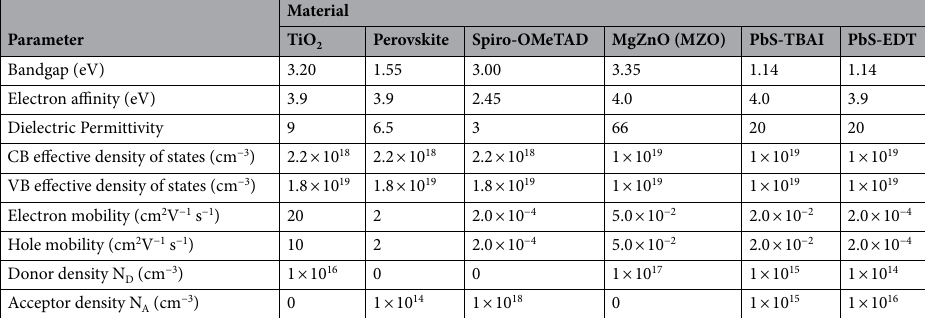
Table 1. Electrical properties of materials used in top cell, bottom cell, and tandem solar cell 8,9,17,32–34,44,45,52 . The second and third-order recombination rates are also considered for the perovskite with the help of charge carrier decay constants, as reported in previous literature 17,50,51 .